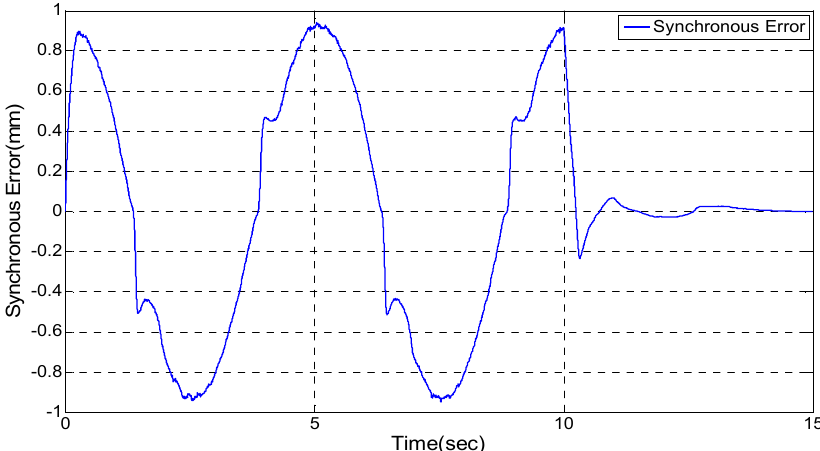
Figure 10. The synchronous error of the cascade synchronous control method.